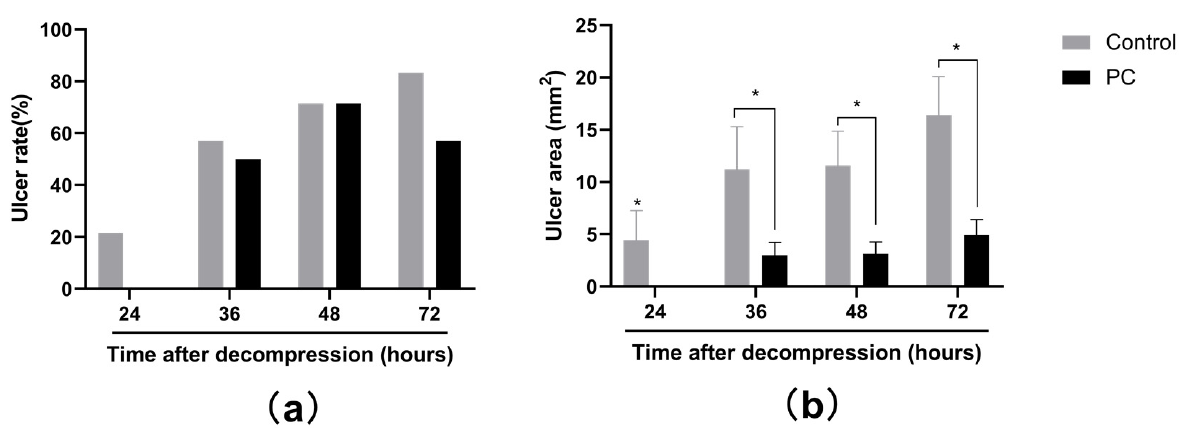
Figure 2. Ulcer rate ( a ) and ulcer area ( b ) after decompression in two groups. * p < 0.05. PC: precon- ditioning.